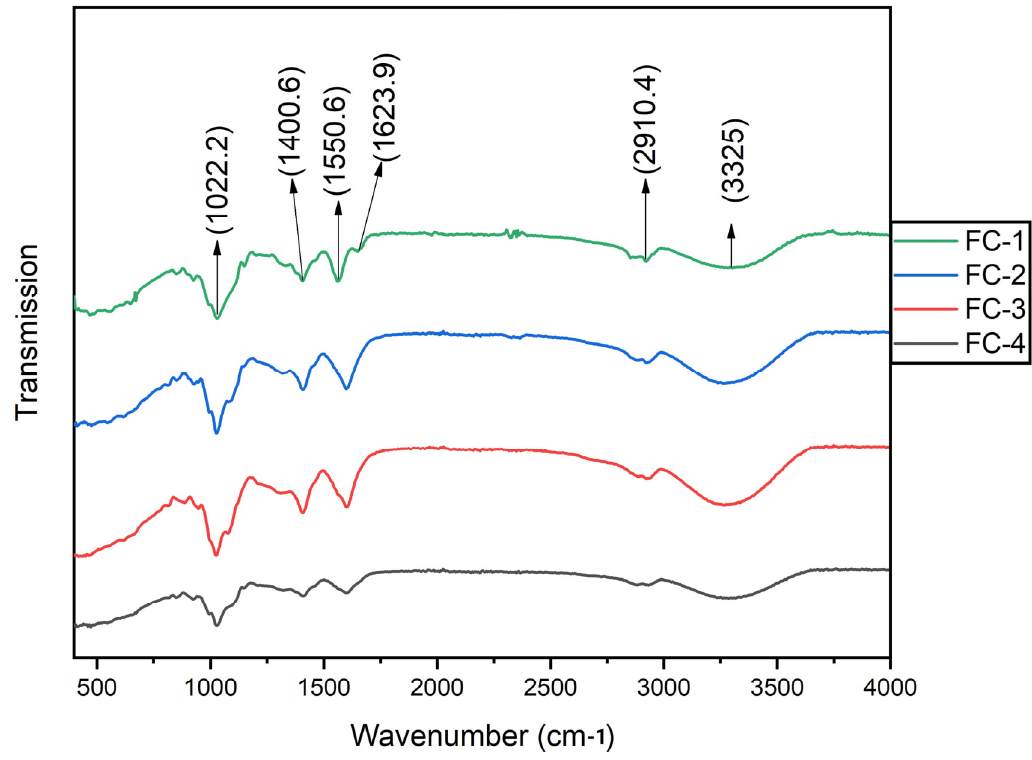
Figure 3. FTIR of CS–SA edible film samples, control or FC-1, CS+ SA; FC-2, CS+ SA+ FFE (0.5%); FC-3, CS+ SA+ FFE (1%); and FC-4, CS+ SA+ FFE